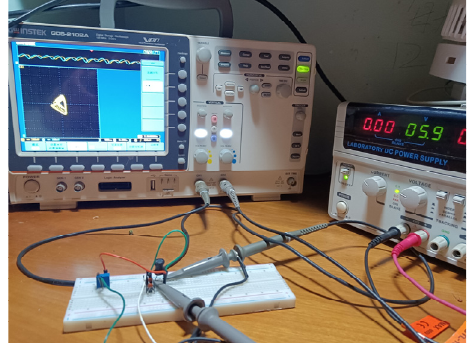
Figure 17. The photo of experimental circuit in operation.